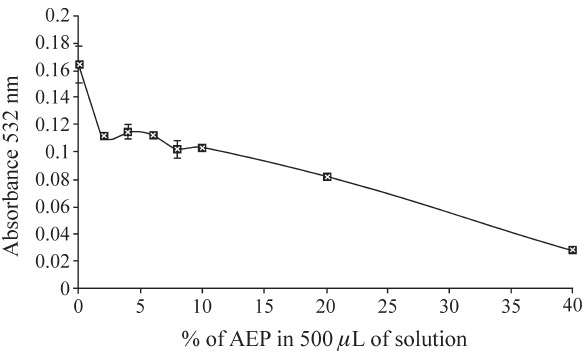
Figure 1 - Kinetics of the oxidation inhibition of 2-deoxyribose by hydro- gen peroxide (H 2 O 2 ). Changes in absorbance ( λ = 532 nm) mean trapping action of AEP on hydroxyl radicals. Absorbencies were read every 5 min for 40